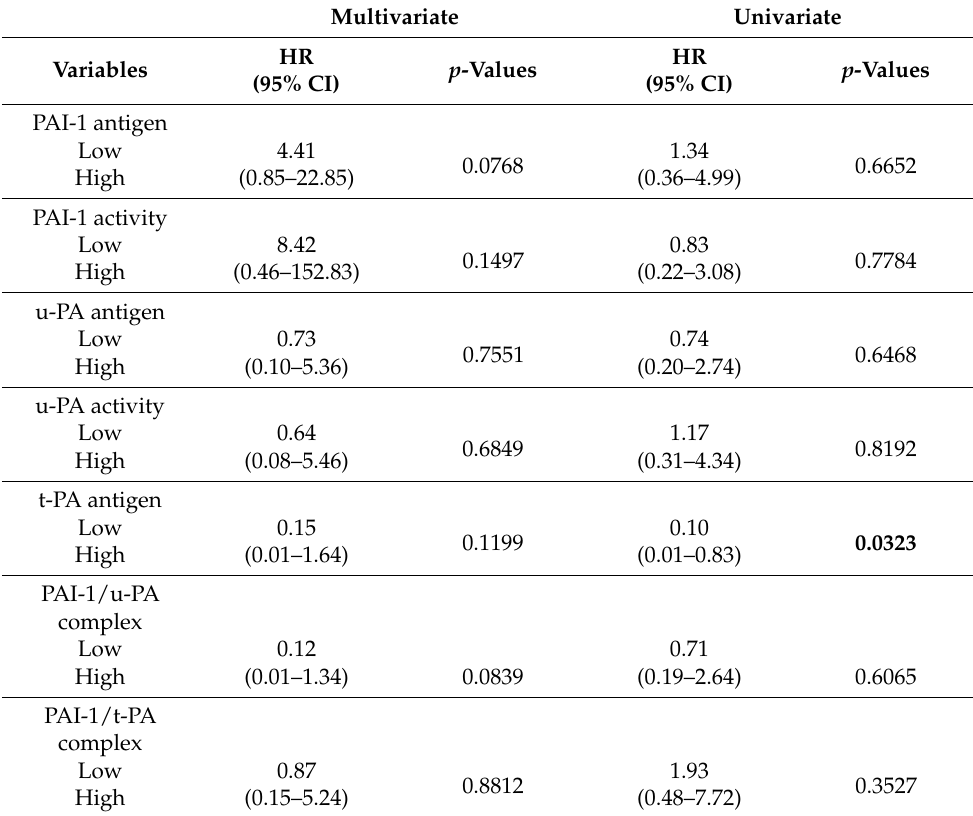
Table 7. The multivariate and univariate Cox regression models for disease-free survival. Multivariate